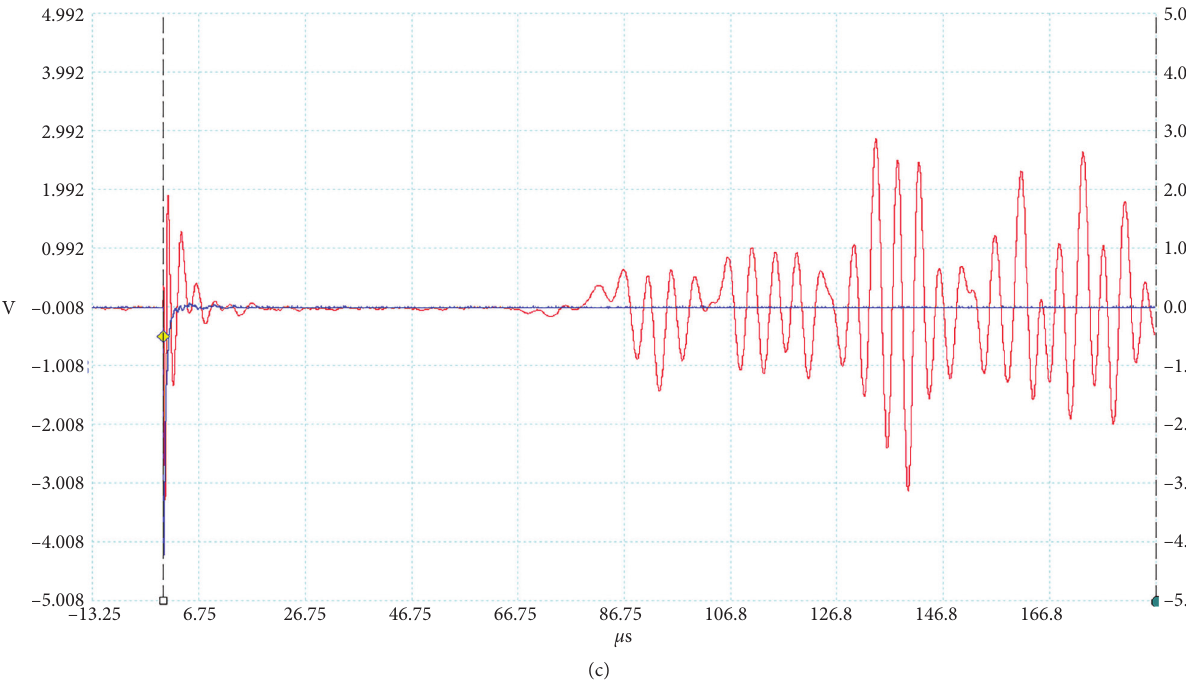
Figure 11: Waveforms recorded at different moments of unloading process. (a) 0.5MPa/min, (b) 1.0MPa/min, and (c) 2.0MPa/min.